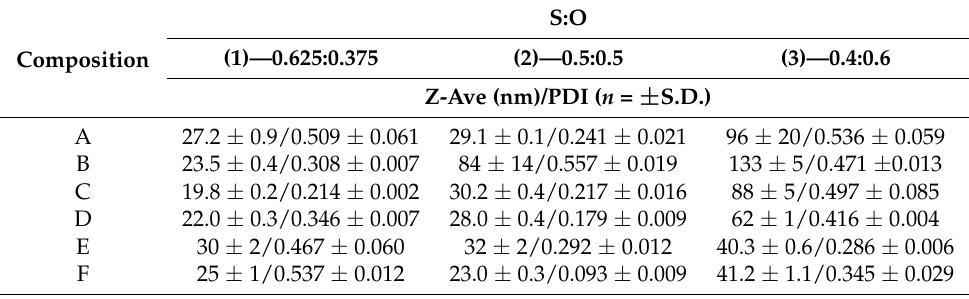
Table 4. The effect of the mass ratio of the surfactant—Etocas 35 (S)—in relation to fragrance composition (O) on the particle size (Z-Ave) and polydispersity index (PDI) of the obtained